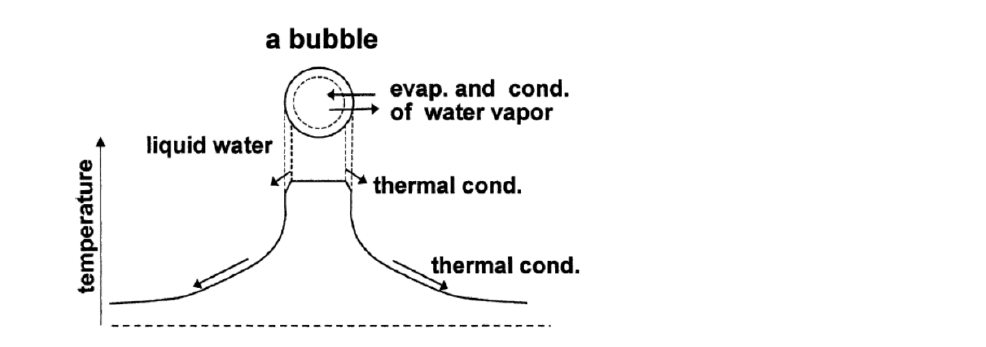
Figure 1. The results of numerical simulation of fundamental equations (PDE) for fluid mechanics inside a collapsing argon bubble under ultrasound ( left ) The bubble radius (solid line) and the op- tical pulse of sonoluminescence (dotted line). ( right ) The spatial profile of the calculated tempera- ture at the given points of a, b, c, and d (filled squares in the left figure). Reprinted with permission from Ref. [109]. Copyright 2006, the American Physical Society.